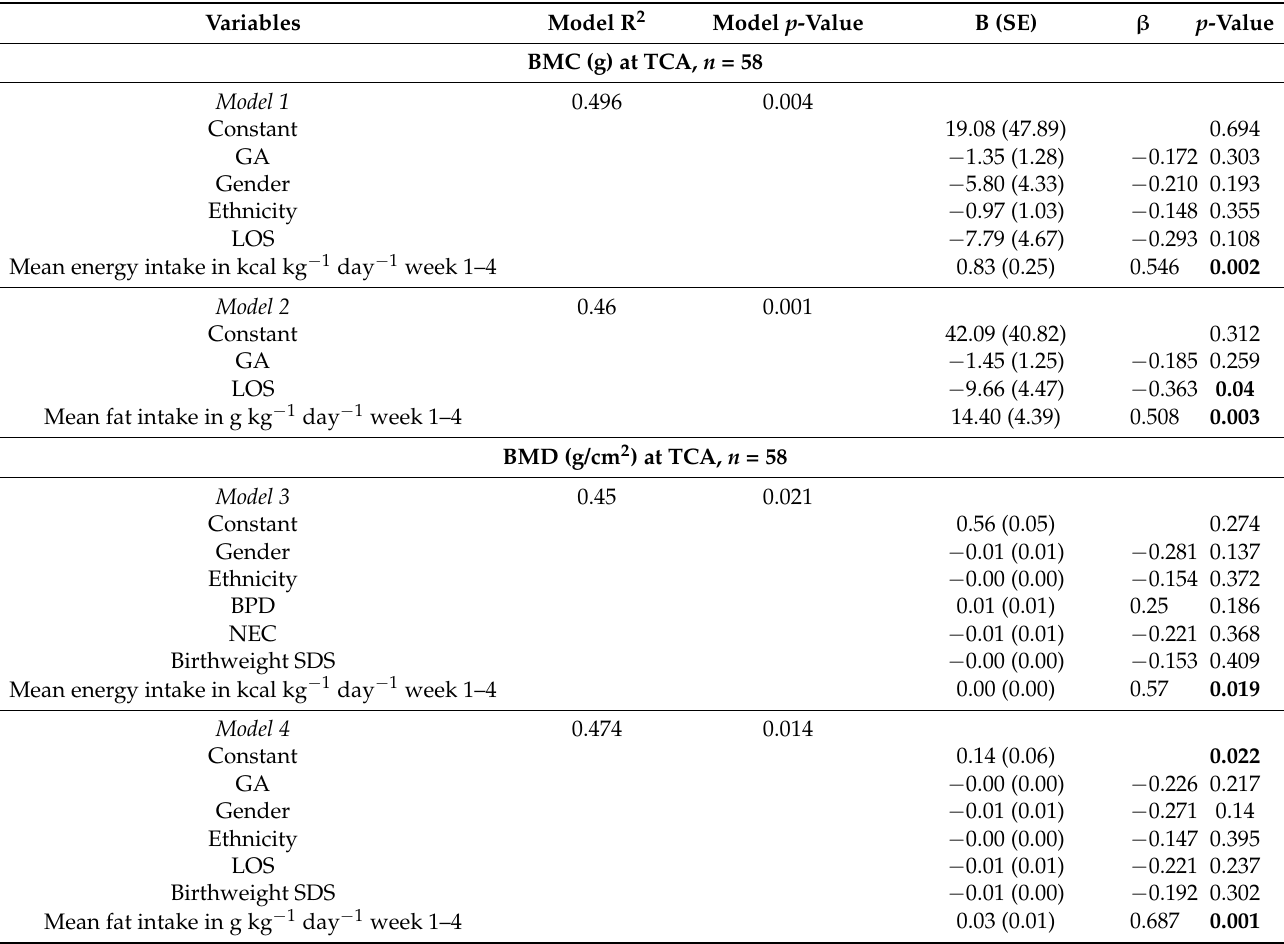
Table 5. Regression analyses of mean intake in the first four postnatal weeks as a predictor for BMC and BMD at